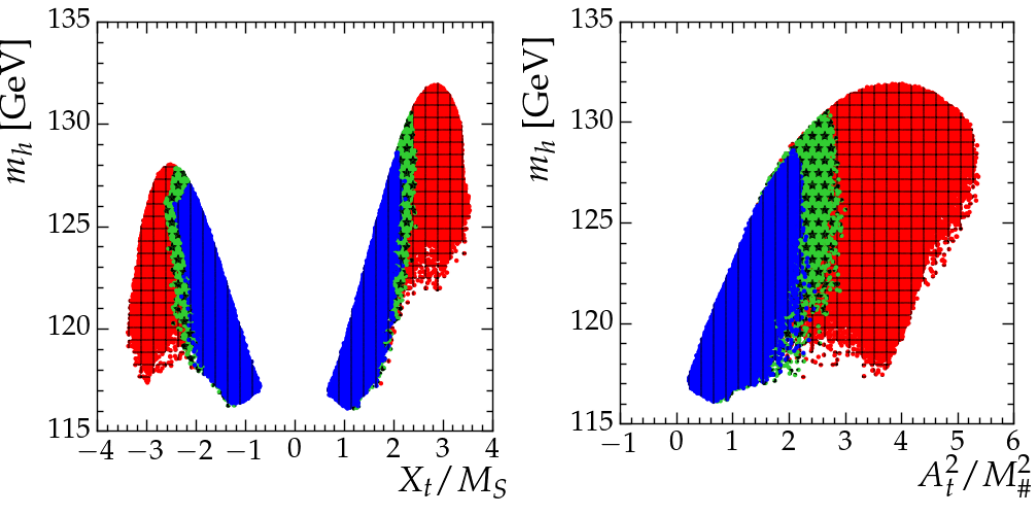
Figure 4 . Left: the variation of m h against X t for the four (cid:12)eld potential with (cid:22) set in the range [1000 ; 1500] GeV. Right: the variation of m h against A 2 to the EWSB vacuum being unstable are given in red (checkered), meta-stable in green (stars) and stable in blue (vertical lines).